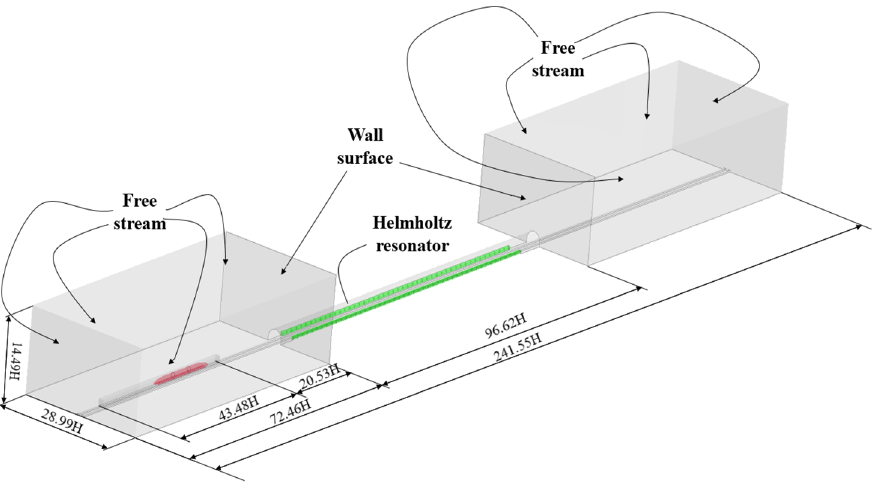
Figure 3. Computational Domain.